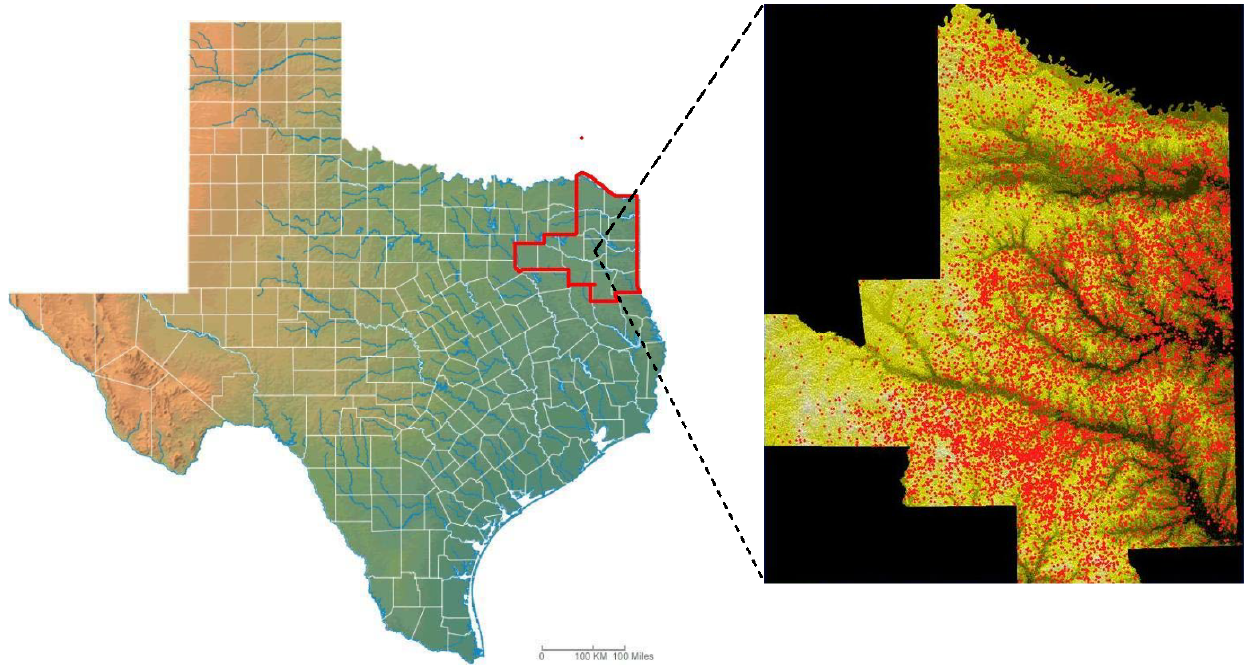
Figure 2. Location of Texas District 12 (TX12) in East Texas [22] and historical fire occurrences, where each dot represent a fire